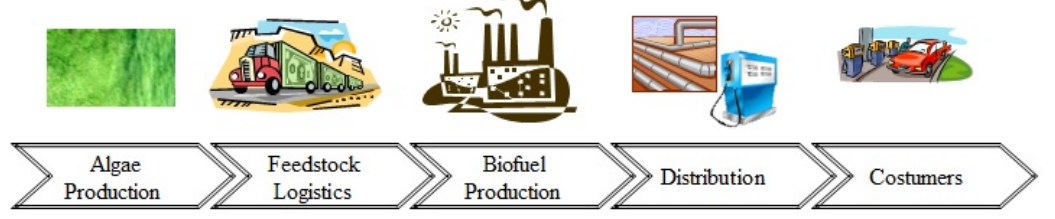
Figure 1. Algae-to-biodiesel supply chain.